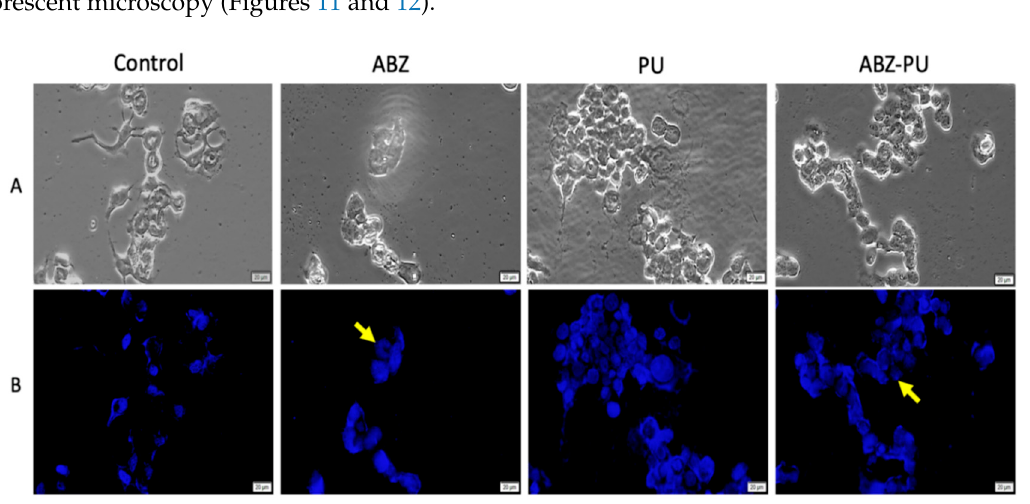
Figure 10. The viability percentage of MCF-7 and MDA-MB-231 cells 24 h post-treatment with test compounds (ABZ, PU and ABZ-PU) at different concentrations (5, 15, 25, 50 and 100 µM). Cell viability was normalized at corresponding concentrations of DMSO-treated cells. (Statistical significance: *: p < 0.05, **: p < 0.01, ***: p < 0.001 and ****: p < 0.0001).